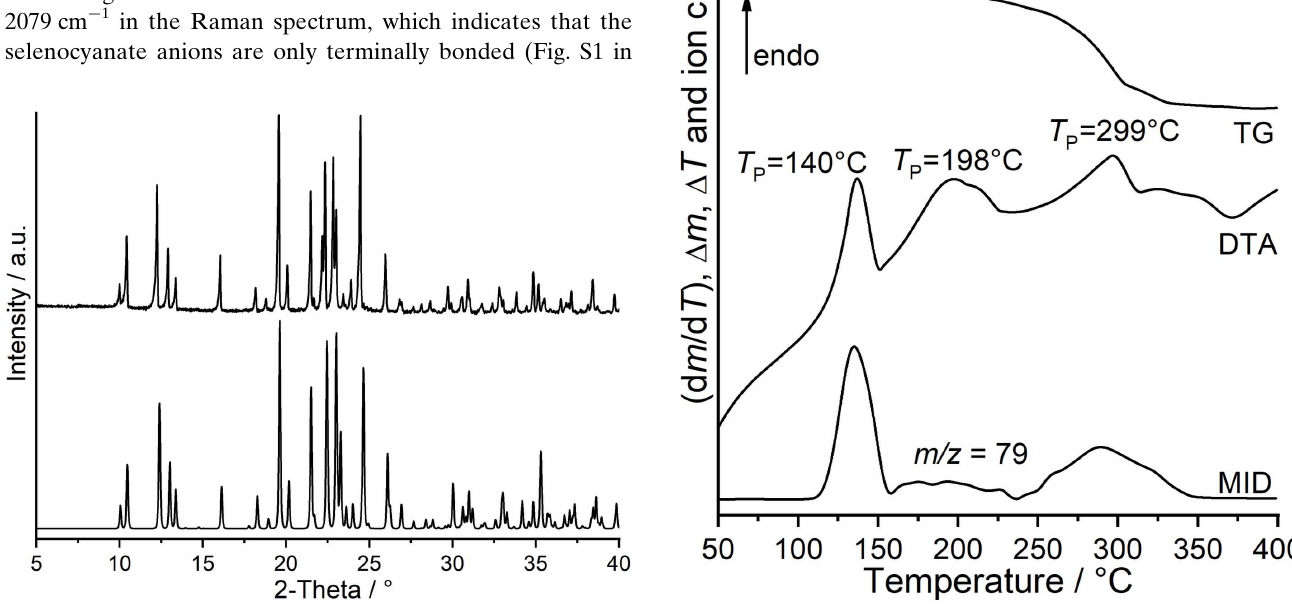
Figure 2 DTG, TG, DTA and MS trend scan curves for the title compound measured at 4 (cid:4) C min (cid:3) 1 in helium.